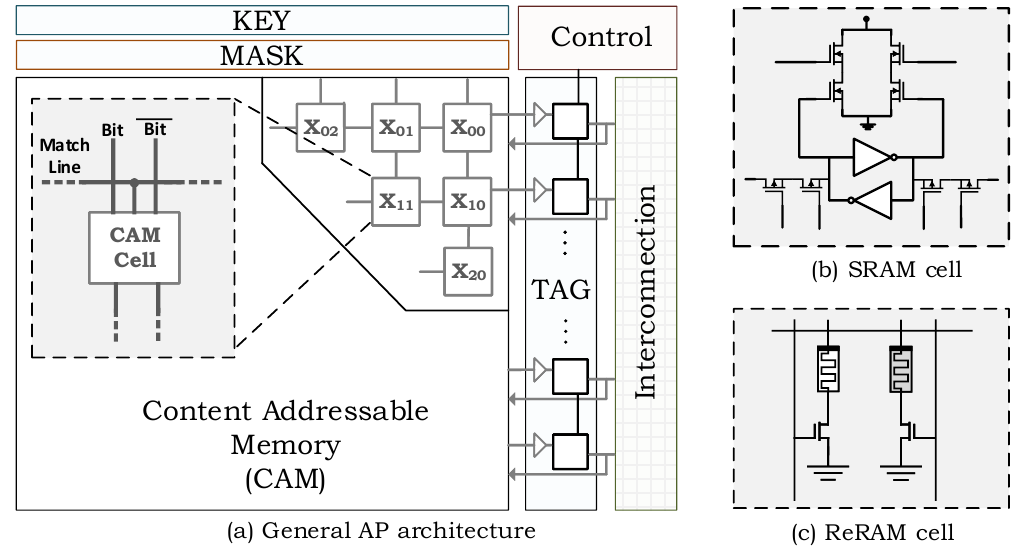
Figure 1. Architecture of an associative in-memory processor with SRAM and ReRAM based cell